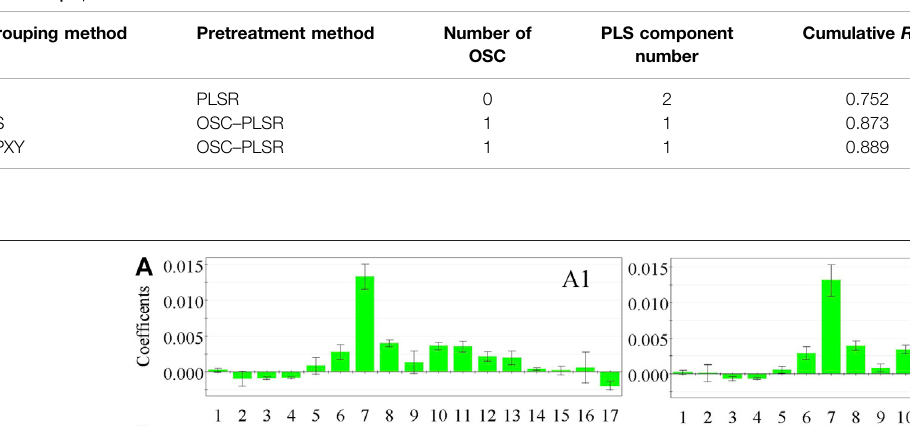
Frontiers in Pharmacology |